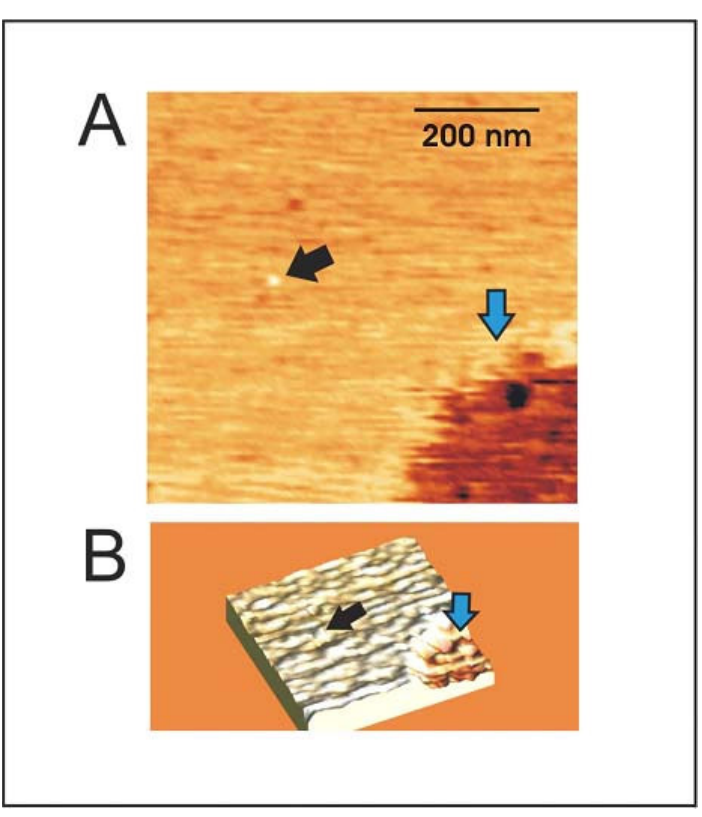
FIGURE 1. The substrate surface of a mica (the area without the DNA molecules, 0.6 µ m 2 ). Hills and holes are indicated by black and blue arrows, respectively. (A) 2D image, the hole zone is in the right bottom; (B) 3D